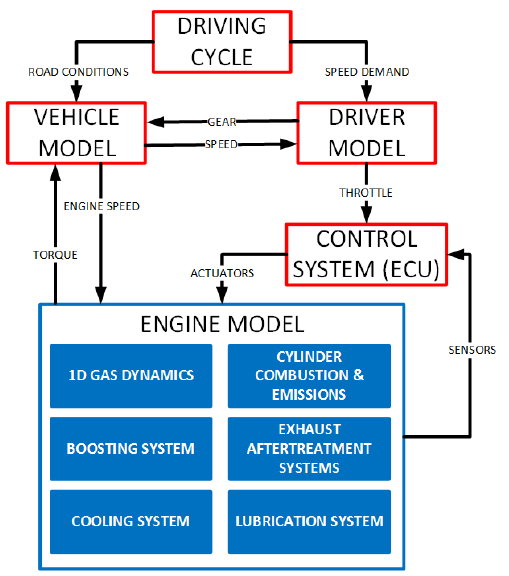
Figure 4. Flow-chart of VEMOD